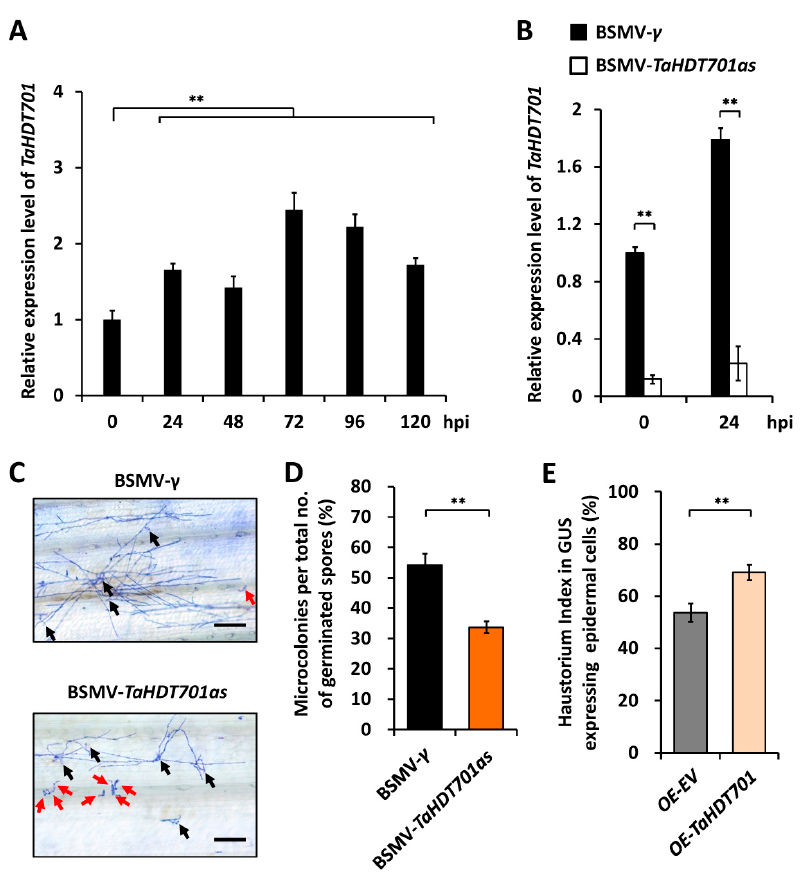
Figure 1. TaHDT701 is a negative regulator of bread wheat resistance to the powdery mildew pathogen Blumeria graminis f.sp. tritici ( Bgt ). ( A ) Expression profiles of TaHDT701 in Yannong 999 leaves during the infection of Bgt virulent isolate E09. ( B ) Transcript abundance of TaHDT701 in Yannong 999 leaves inoculated with barley stripe mosaic virus (BSMV)- γ and BSMV- TaHDT701as. ( C ) Bgt microcolony formation type on wheat plants infected with BSMV- γ and BSMV- TaHDT701as. Conidia that germinated and finally established microcolonies are indicated with black arrows, and conidia that germinated but failed to establish microcolonies are indicated with red arrows. Bar, 150 µ m. ( D ) Statistical analysis of Bgt microcolony formation on BSMV- γ and BSMV- TaHDT701as wheat leaves. For each treatment, at least 500 Bgt- wheat interaction sites were separately counted. ( E ) Statistical analysis of Bgt haustorial formation in wheat epidermal cells bombarded with OE- EV or OE- TaHDT701 . At least 50 cells were analyzed in one experiment. For ( A ), ( B ), ( D ), and ( E ), three independent biological replicates per treatment were statistically analyzed ( t -test, ** p < 0.01).